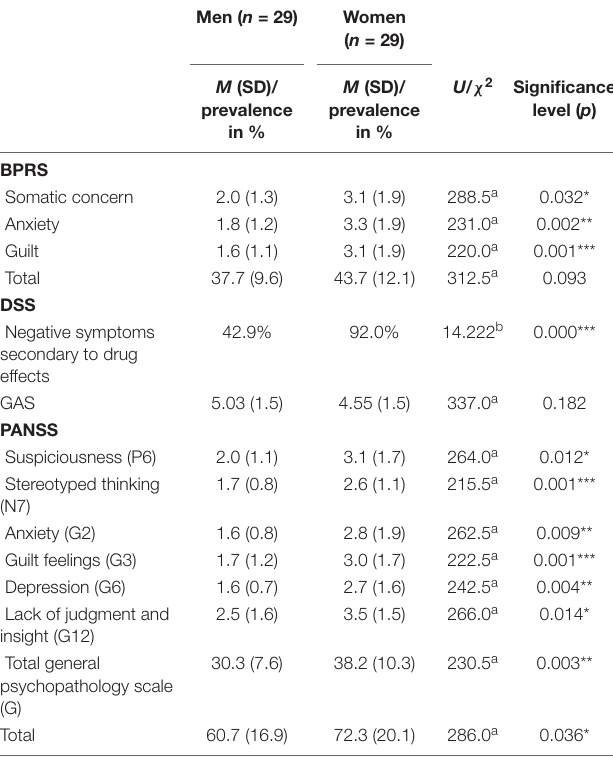
TABLE 2 | Differences in the psychopathological features between male and female forensic in-patients with